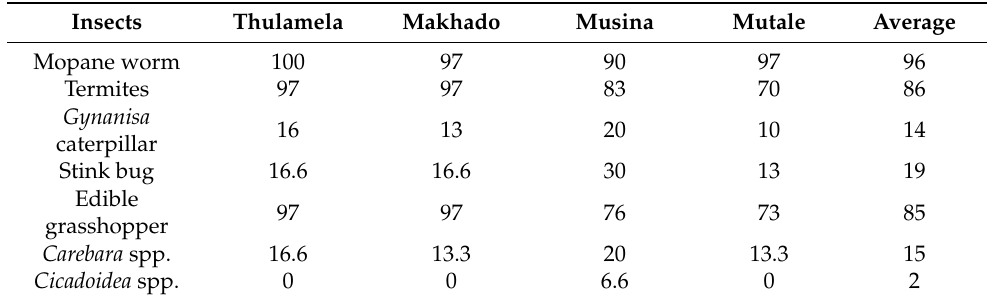
Table 6. Percentage of respondents that consumed insects across four municipalities in Vhembe district in Limpopo, South Africa.